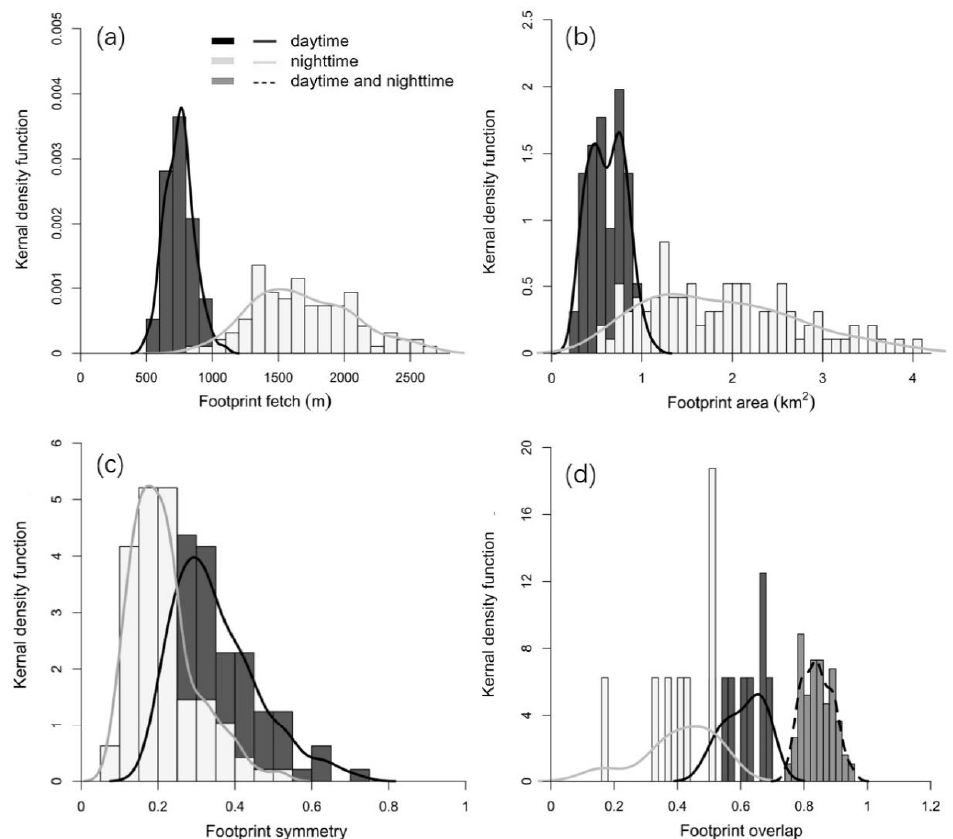
Figure 2. Kernel density distribution of footprint fetch from the 80% footprint climatology contour ( a ), the source area within the 80% footprint climatology contour ( b ), the footprint symmetry index ( c ) and the footprint overlap index for seasonal and daytime – nighttime overlaps ( d ).